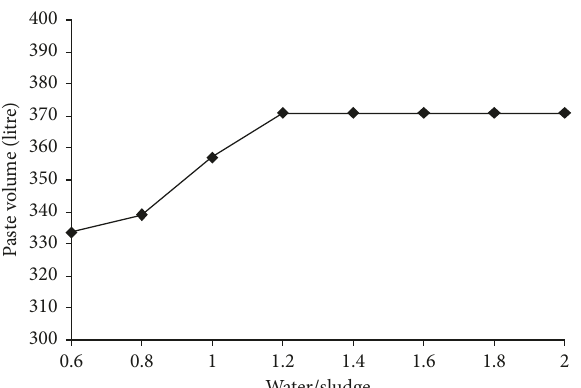
Figure 8: The effect of the water/sludge ratio on the paste volume of SCC.